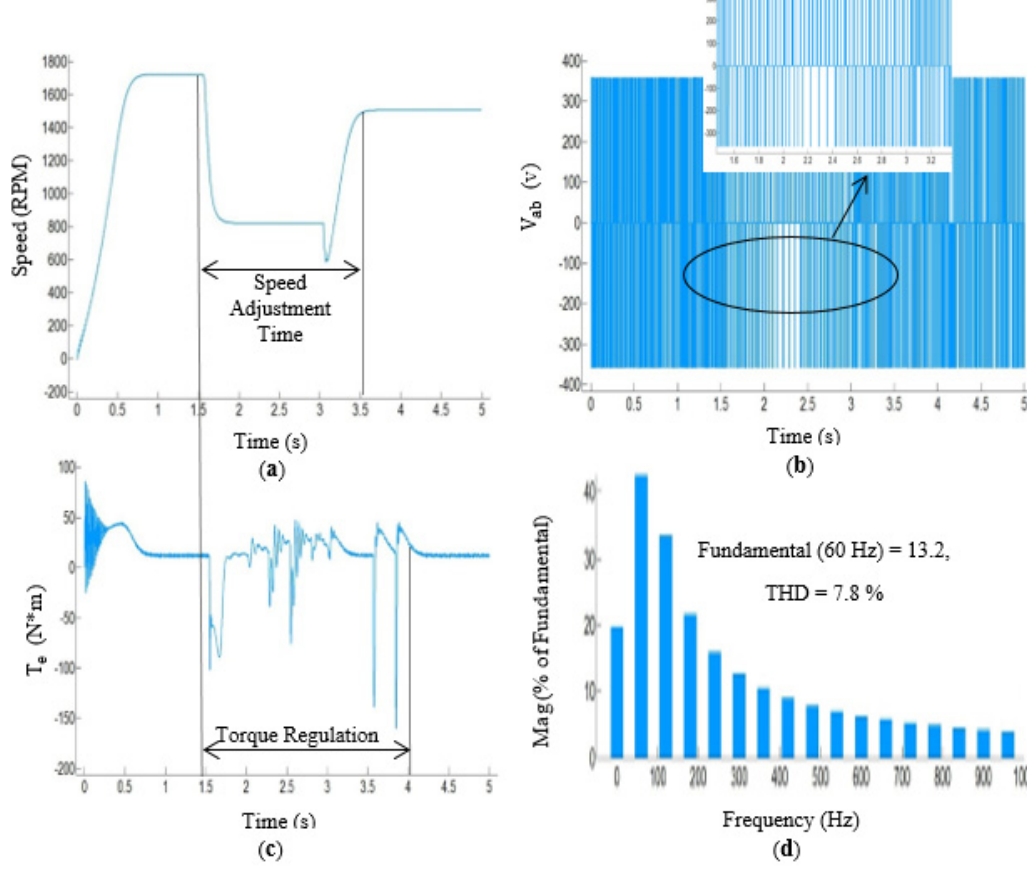
Figure 8. Transient effect of load variation on: ( a ) motor speed; ( b ) variable frequency drive (VFD) phase-to-phase output voltage; ( c ) motor electric torque; and ( d ) current harmonic distortion rate.